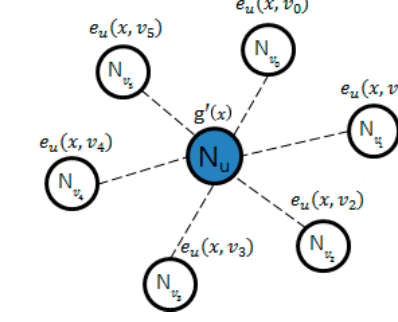
Figure 3. Group key distribution.